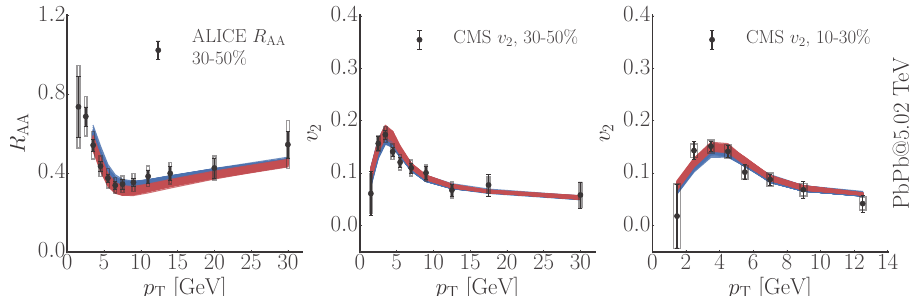
Figure 1: (Color online) 200 random parameters x = ( α, β, γ ) sampled from the posterior distribution and evaluated by emulators. A selections of the output – D -meson R AA and v 2 at PbPb collisions at 5.02 TeV are compared with experimental